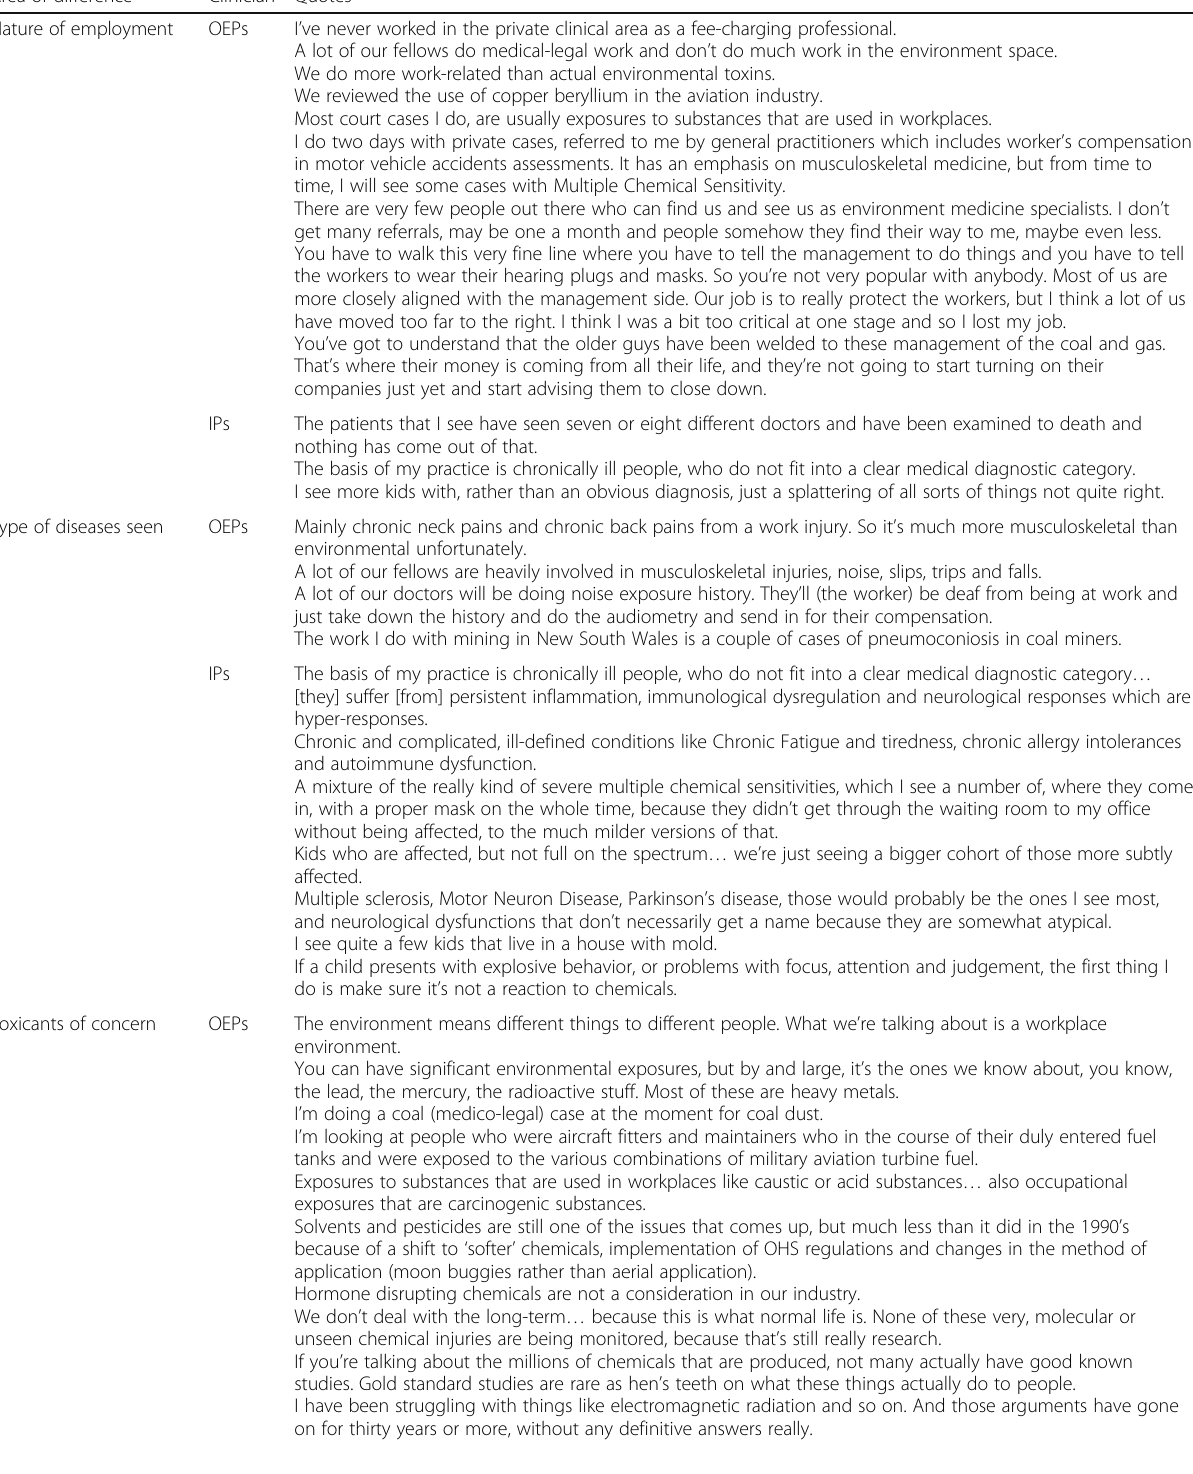
Table 1 Environmental medicine is a divided profession Area of